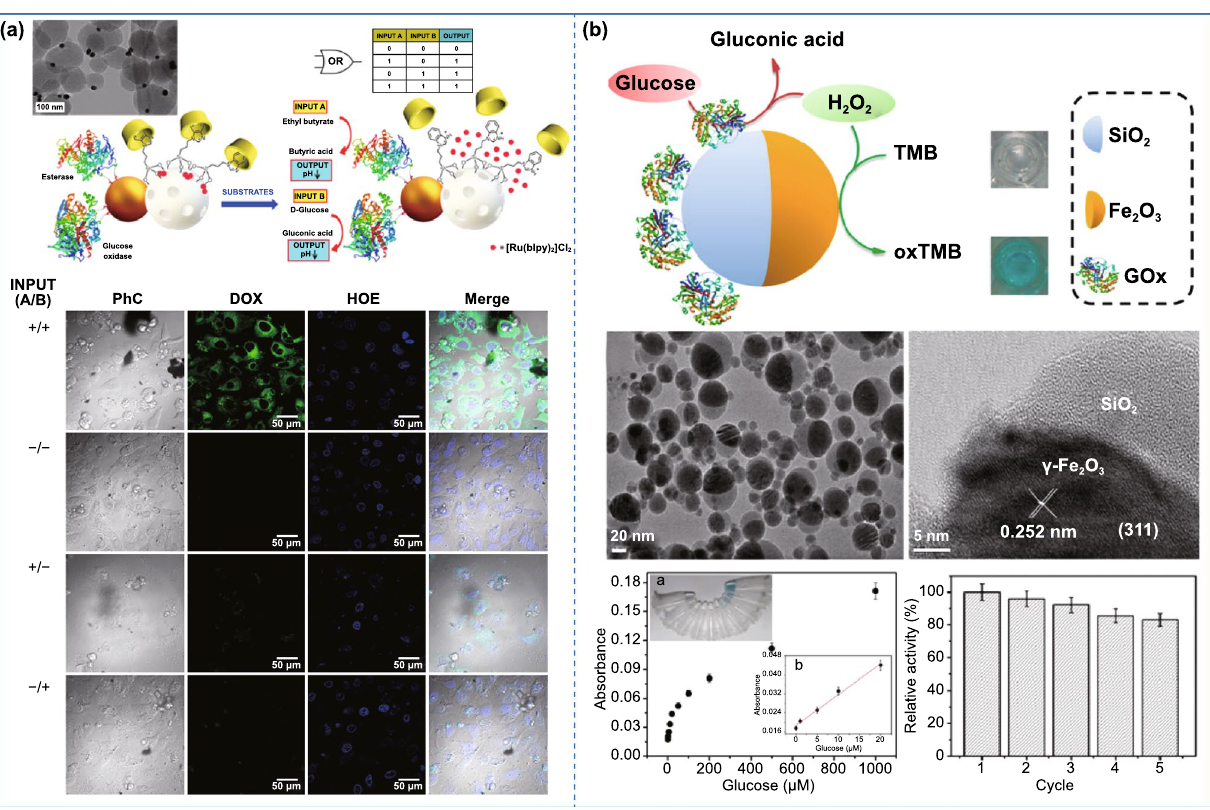
Fig. 14 Application of asymmetric structure in others. a Application of Janus gold-mesoporous silica nanoparticles in logic gate. Reproduced with permission from Ref. [149]. Copyright 2014, American Chemical Society. b Application of Janus particles in sensors. Reproduced with permission from Ref. [151]. Copyright 2015, American Chemical